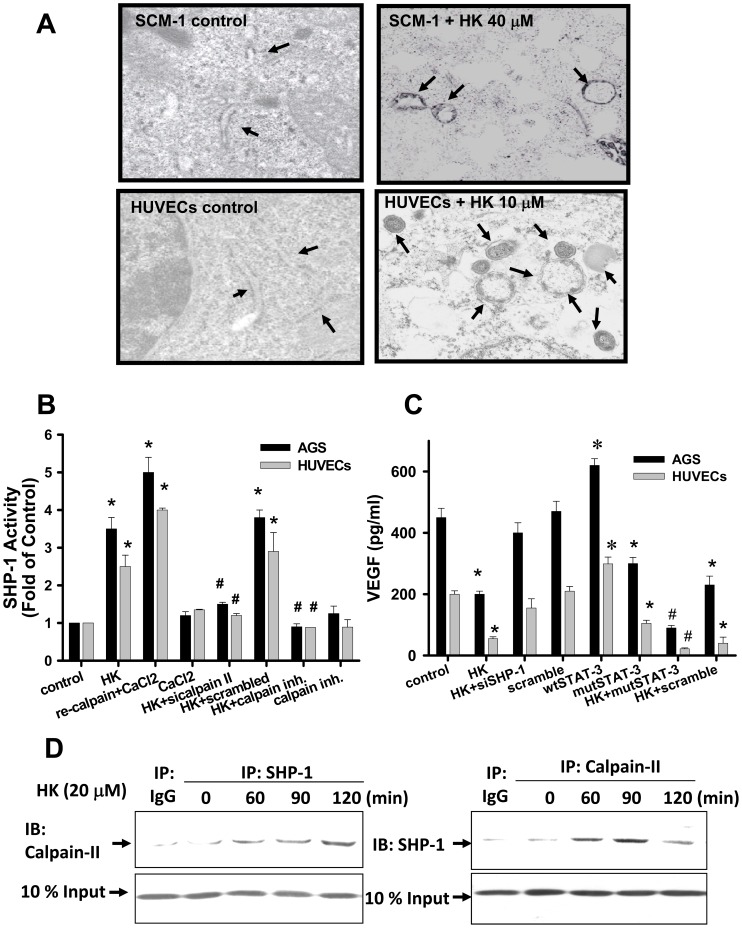
Effects of honokiol on ER structure, SHP-1 activity, and VEGF generation.(A) Cells were treated with honokiol (HUVECs, 10 µM; SCM-1, 40 µM) for 18 h. Cells were collected and visualized by electron microscopy as described in “Materials and Methods”. Arrows indicate dilated ER. Original magnification: 9800x. (B) Cells were treated with or without honokiol (HUVECs, 20 µM; AGS, 20 µM) in the presence or absence of recombinant protein of calpain II (re-calpain) or calpain II siRNA transfection, and then cells were analyzed for SHP-1 activity. (C) Cells were transfected with wild type STAT-3 (wt) and mutant STAT-3 (mut) plasmids or SHP-1 siRNA, and then the VEGF generation was determined. (D) Interaction of calpain and SHP-1 was detected in AGS cells. Immunoprecipitated proteins were collected and subjected to SDS-PAGE and immunoblotting with anti-calpain-II or anti-SHP-1 antibodies. In A and D, results shown are representative of at least 4 independent experiments. In B and C, data are presented as mean ± SEM (n≥4). *P<0.05 as compared with control. #P<0.05 as compared with honokiol alone.